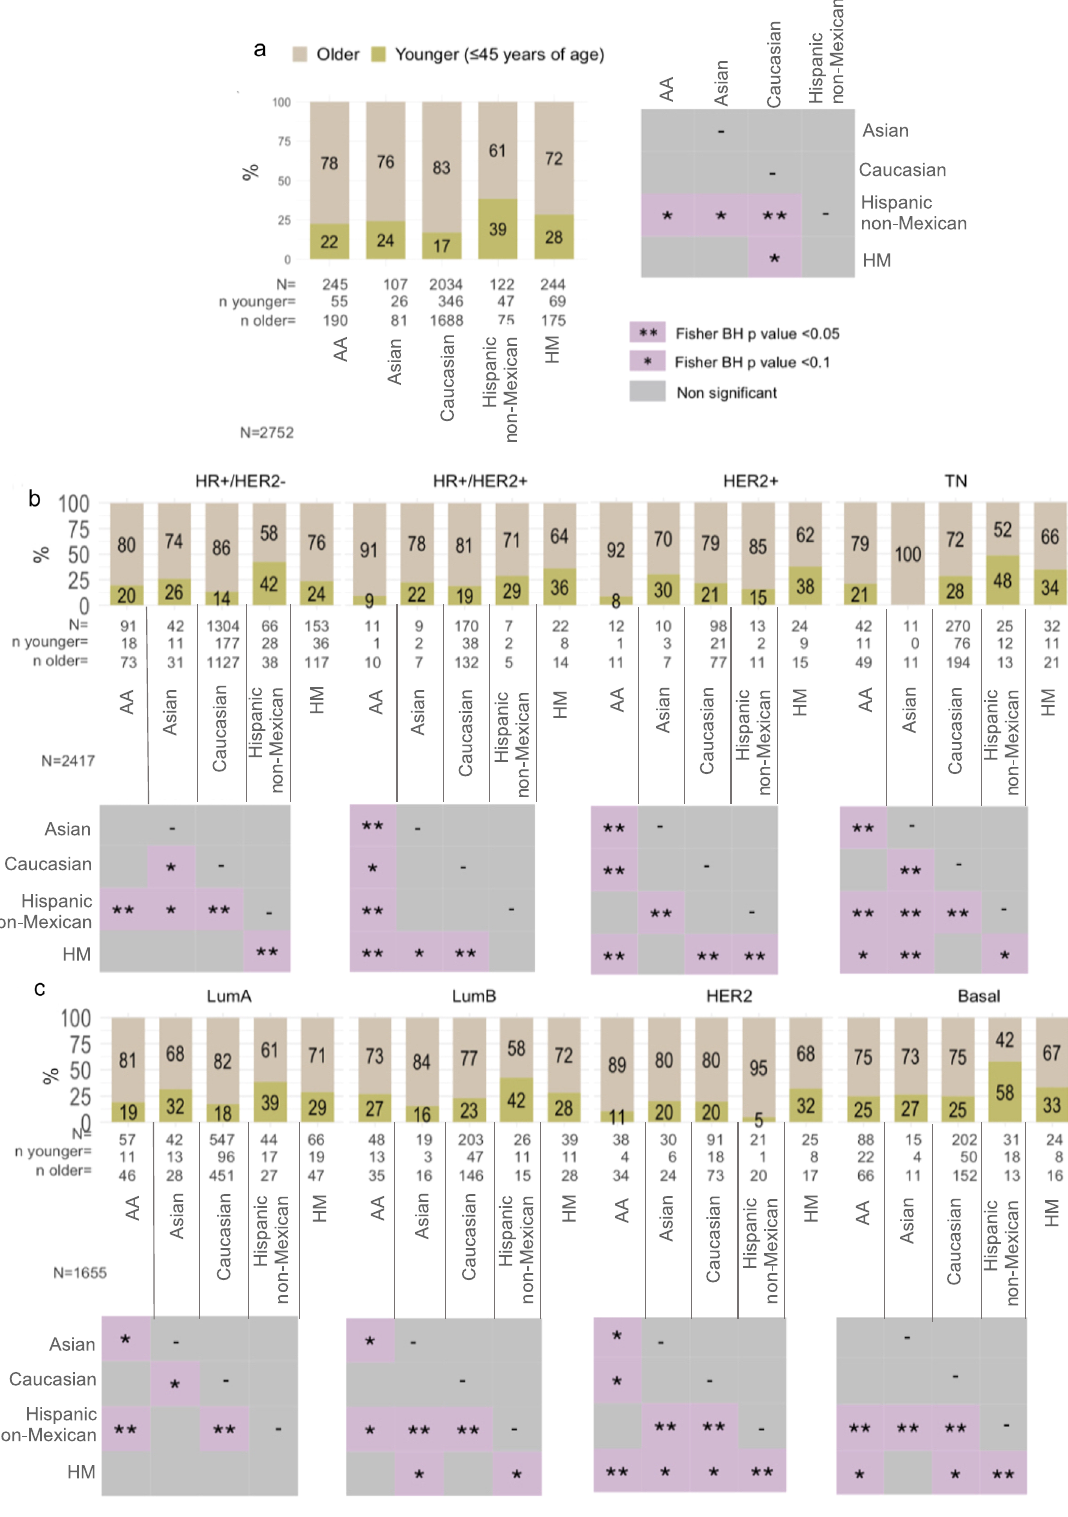
NATURE COMMUNICATIONS| (2021) 12:2245